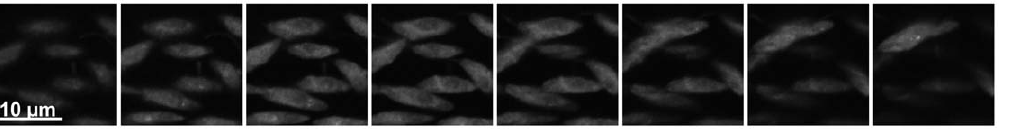
Figure 3. Mitochondrial morphology studied by laser scanning microscopy. PFA-fixed L. tarentolae promastigotes (Fig. 1A,B) were analyzed by laser scanning microscopy using a Zeiss LSM780 microscope and the software ZEN 2010. Z-stacks at Z increments of 0.41 m m are shown from left to right. A 458 nm laser served as a light source.